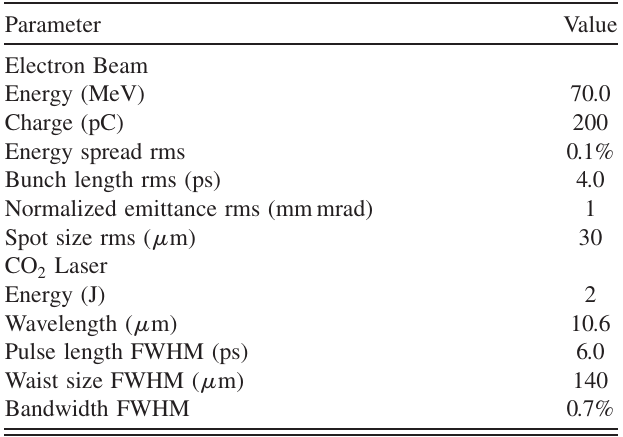
TABLE I. Electron beam and CO 2 laser parameters at the interaction point.